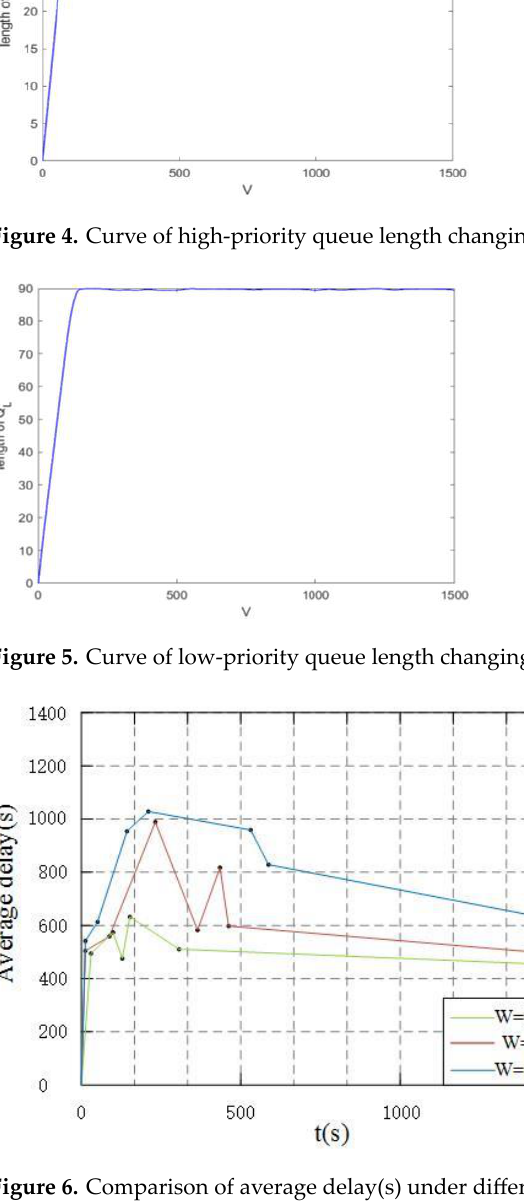
Figure 6. Comparison of average delay(s) under different packet arrival rates.